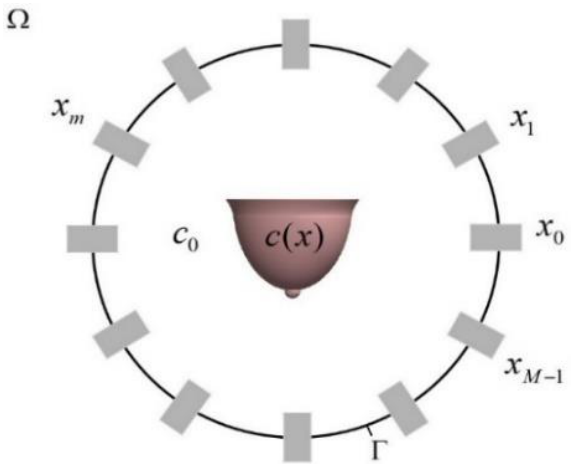
Figure 4. Sound speed ultrasound tomography setup.